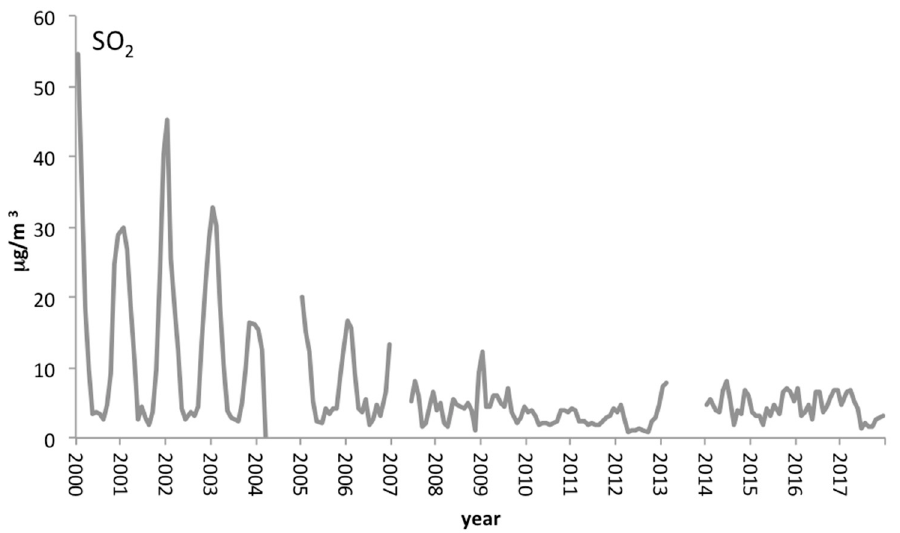
Figure 2. SO 2 concentrations trend registered for Milan monitoring sites (data from ARPA Lombardia) from 2000 until today.